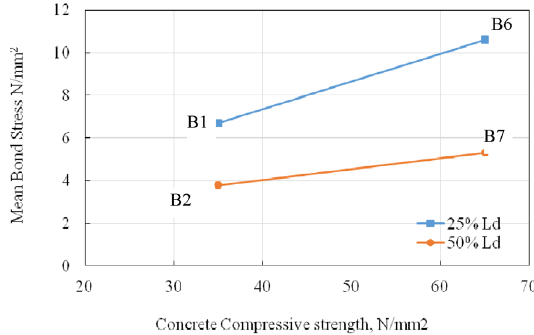
Fig. 15 Bond stress for beams B1, B2, B6 and